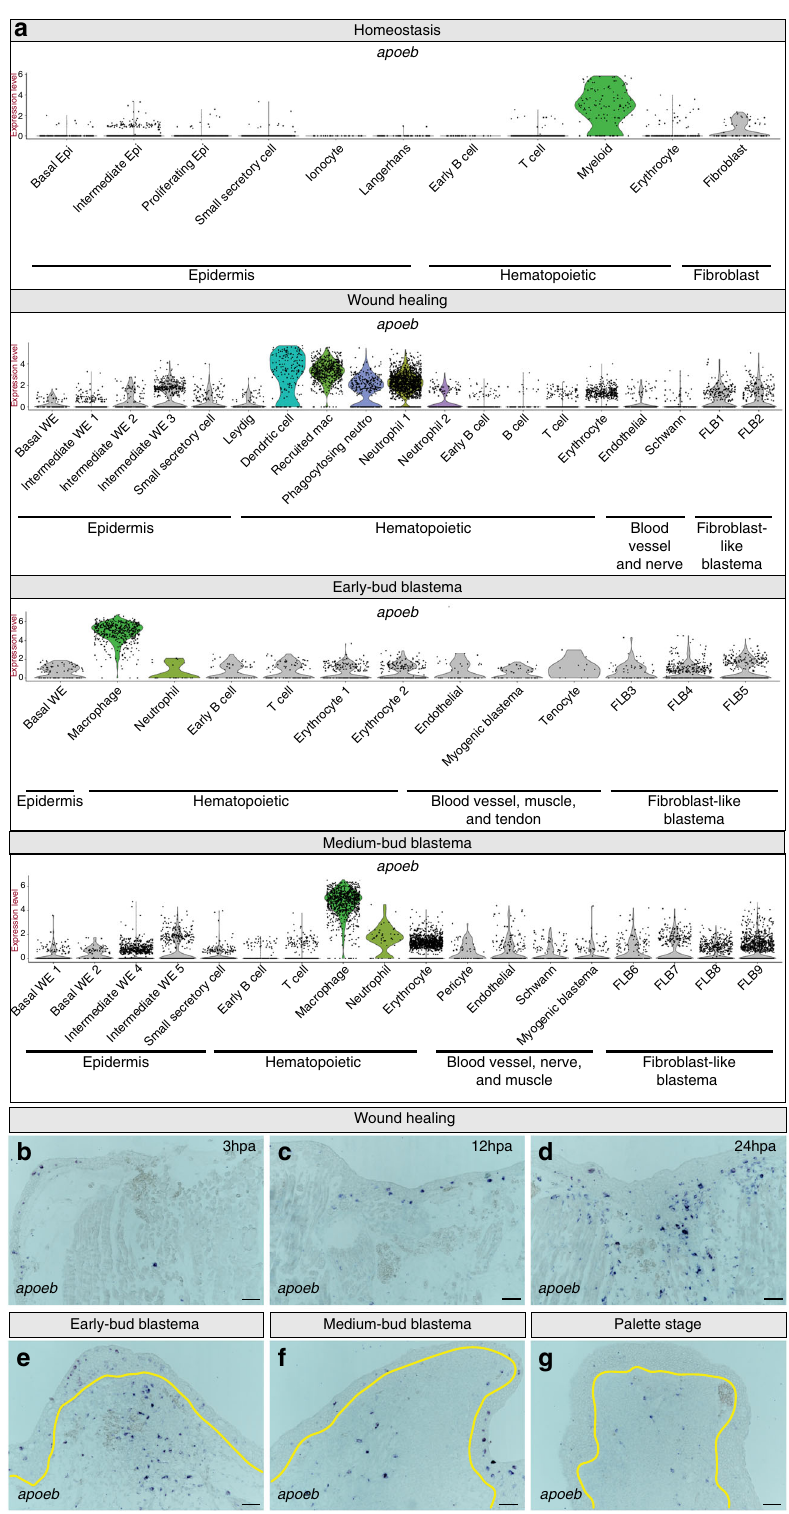
Fig. 5 Myeloid cells are present throughout the course of regeneration. a Violin plots depicting log 2 values of normalized expression of myeloid cell enriched apoeb . Each dot represents an individual cell; myeloid cell populations are in color, while all other populations are in gray. b – g Representative RNA in situ hybridizations probing for apoeb across a time course of regeneration. b – g Magni fi cation ×10 during wound healing, speci fi cally at b 3 h post amputation (hpa), c 12hpa, and d 24hpa. e – g Magni fi cation ×10 of a e early-bud blastema, f medium-bud blastema, and a g palette stage-regenerating limb; yellow line denotes border of blastema and WE. All scale bars are 100 μ m. n = 4 animals per time